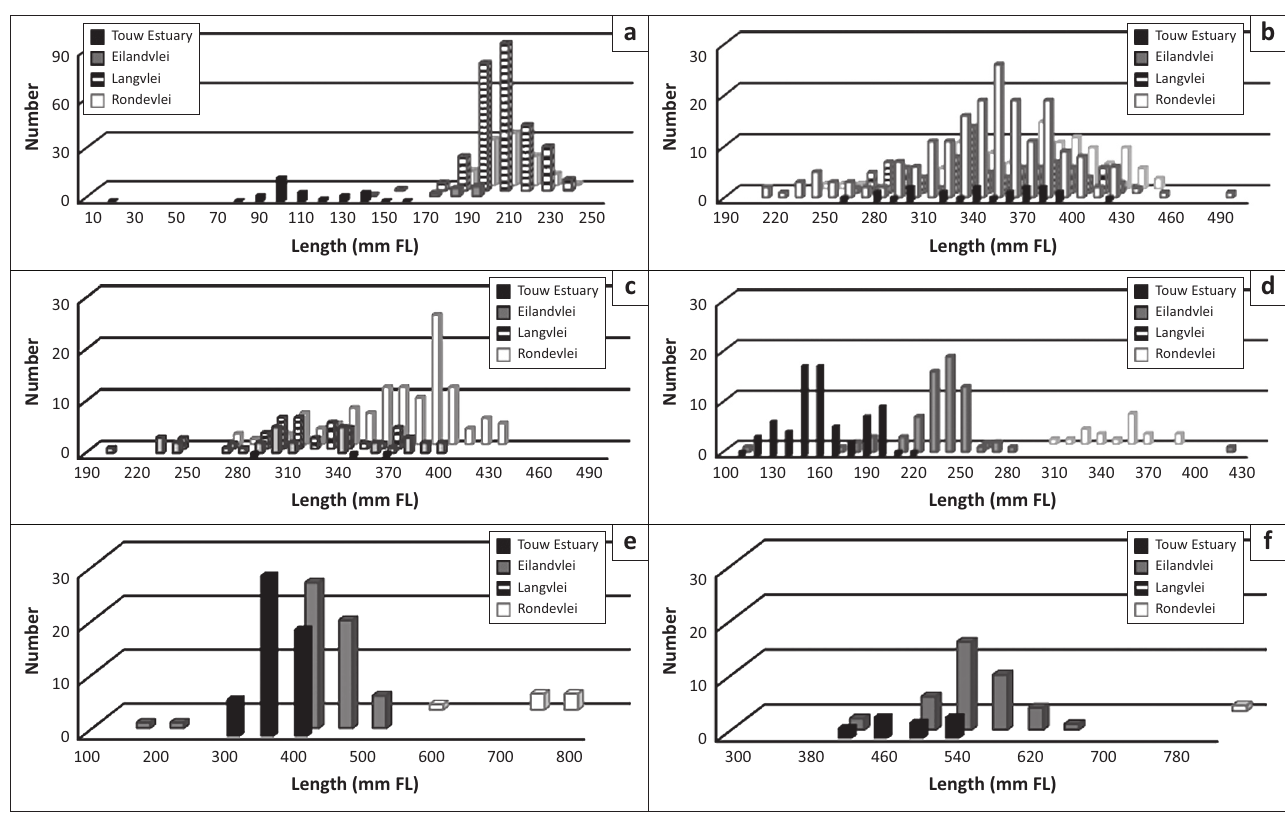
FIGURE 3: Length frequency of (a) Monodactylus falciformis, (b) Liza richardsonnii, (c) Myxus capensis, (d) Rhabdosargus holubi , (e) Lithognathus lithognathus and (f) Pomadasys commersonnii captured in the Wilderness Lakes System between April 2010 and May